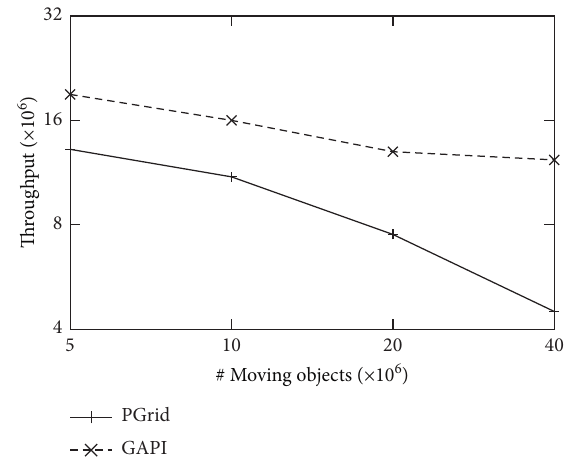
Figure 6: Effect of throughput on the number of moving